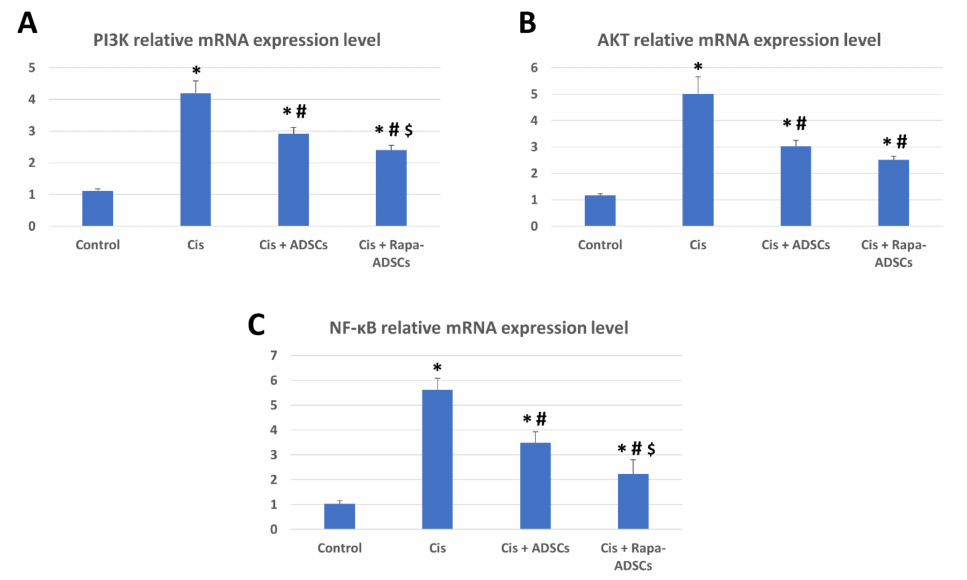
Figure 7. The effects of administering rapamycin-preconditioned ADSCs on liver PI3K-AKT signaling pathway and NF- κ B gene expression in cisplatin (Cis)-induced liver damage. ( A ) PI3K relative mRNA expression in the study groups. ( B ) AKT relative mRNA expression in the study groups. ( C ) NF- κ B relative mRNA expression in the study groups. Cis, cisplatin (i.p. injection of 5 mg/kg in 0.9% saline) group; Cis + ADSCs, cisplatin group receiving ADSCs (one million cells, intravenous in tail vein); Cis + Rapa-ADSCs, cisplatin group receiving same number of ADSCs preconditioned with rapamycin (50 nM/L, 2 h prior to administration). Statistical significance, * vs. control group ( p < 0.01), # vs. Cis group ( p < 0.01) and $ vs. Cis+ADSCs group ( p <